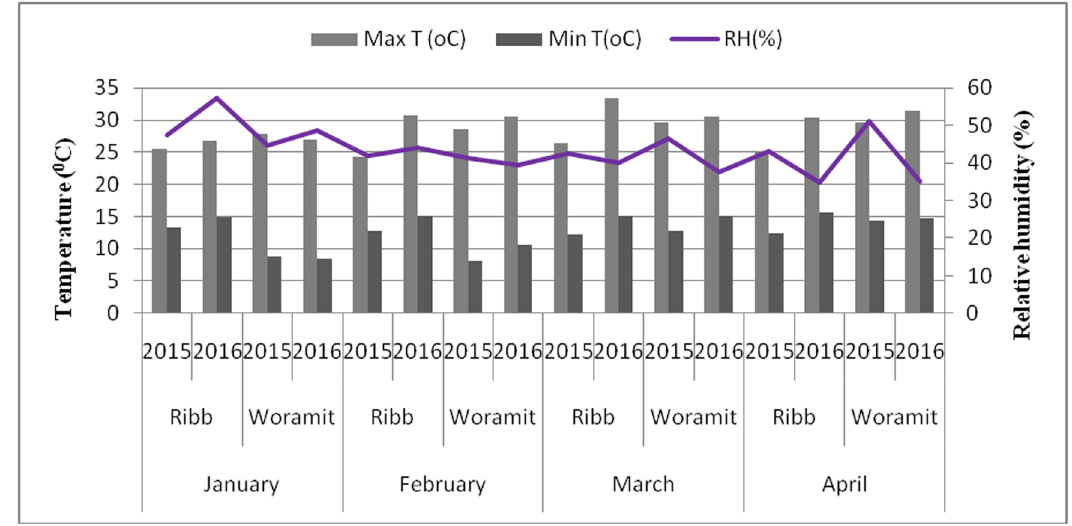
Figure 1: Environmental conditions of the study areas during the experimental